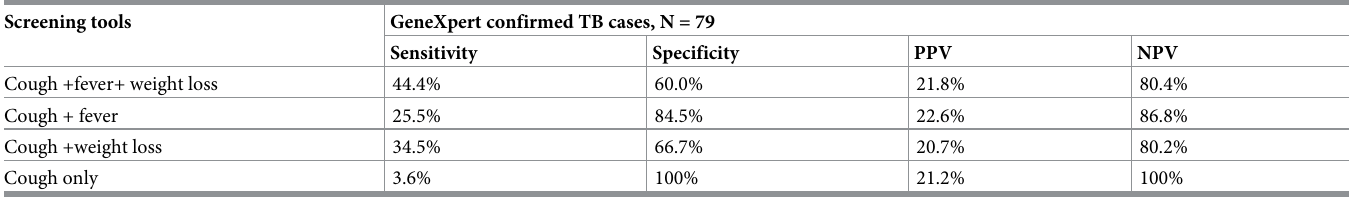
Table 2. Sensitivity, specificity, PPV and NPV TB screening tool among PLHIV, Asella Teaching and Referral Hospital 2019. Screening